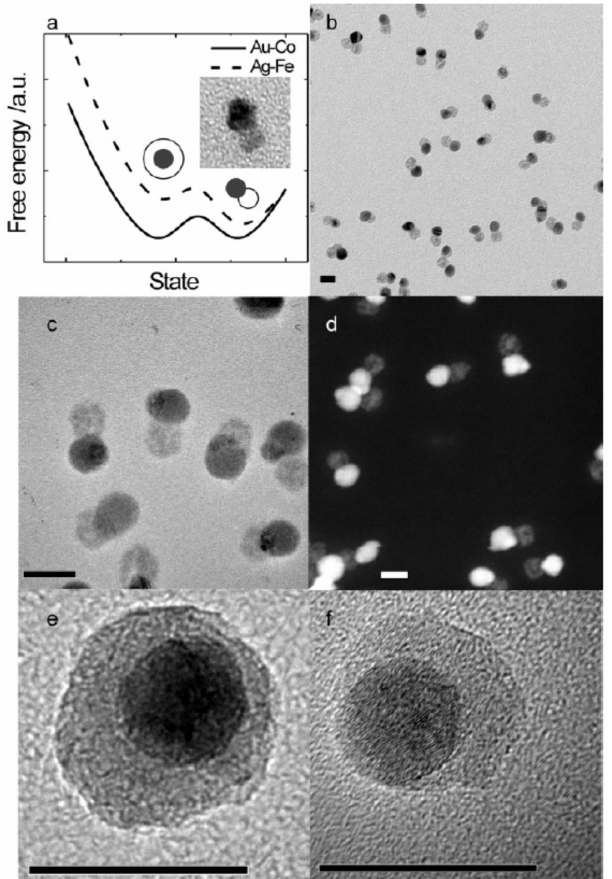
Figure 14. ( a ) Schematic diagram of the local energy minima separating the core–shell and Janus structures for Co-Au and Fe-Ag, with the inset showing one of the rare Co-Au Janus particles. ( b ) Wide field TEM image showing the common occurrence of Fe-Ag Janus particles. ( c , d ) Higher- magnification BF TEM and HAADF images of Fe-Ag nanoparticles, respectively. ( e , f ) Particles transitioning from the core–shell to the Janus structure. All scale bars are 20 nm. Reproduced with permission from